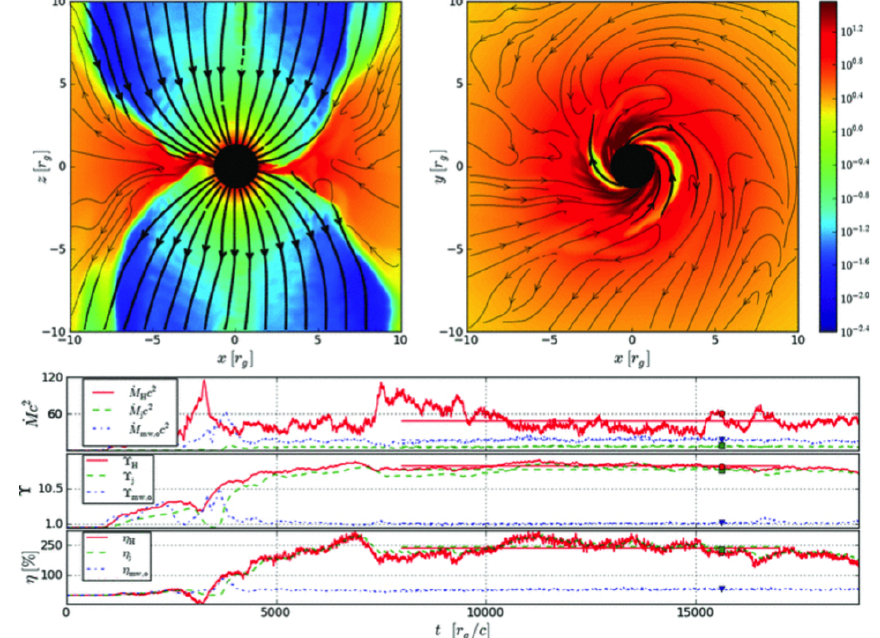
Figure 2. Evolved snapshot of an initially weakly magnetized thick accretion disc around a rotating BH at t = 15,612 r g / c ( r g ≡ GM BH / c 2 , where M BH is the BH mass). Top panels show the logarithm of rest-mass density in color (see the legend on the right-hand side) in both the z – x plane at y = 0 ( top left-hand panel ) and the y – x plane at z = 0 ( top right-hand panel ). The black lines trace field lines, where the thicker black lines show where field is lightly mass-loaded. The bottom panel has three subpanels. The top subpanel shows ˙ M through the BH ( ˙ M H ), out in the jet ( ˙ M j , at r = 50 r g ), and out in the magnetized wind ( ˙ M mw,o , at r = 50 r g ) with legend. The middle subpanel shows the magnetic flux ( Υ ) for similar conditions. The bottom subpanel shows the efficiency ( η ) for similar conditions. Horizontal lines of the same colors show the averages over the averaging period, while square/triangle/circle tickers are placed at the given time and values. A sustained efficiency for η H , the power flowing out of the BH over rest-mass energy flux flowing into the BH, demonstrates the net energy extraction from spinning BHs via the BZ/Penrose mechanism. (Figure 4 of